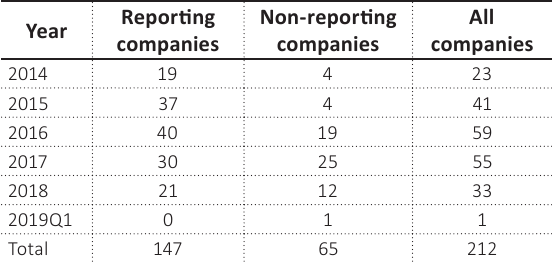
Table 1. Data sample